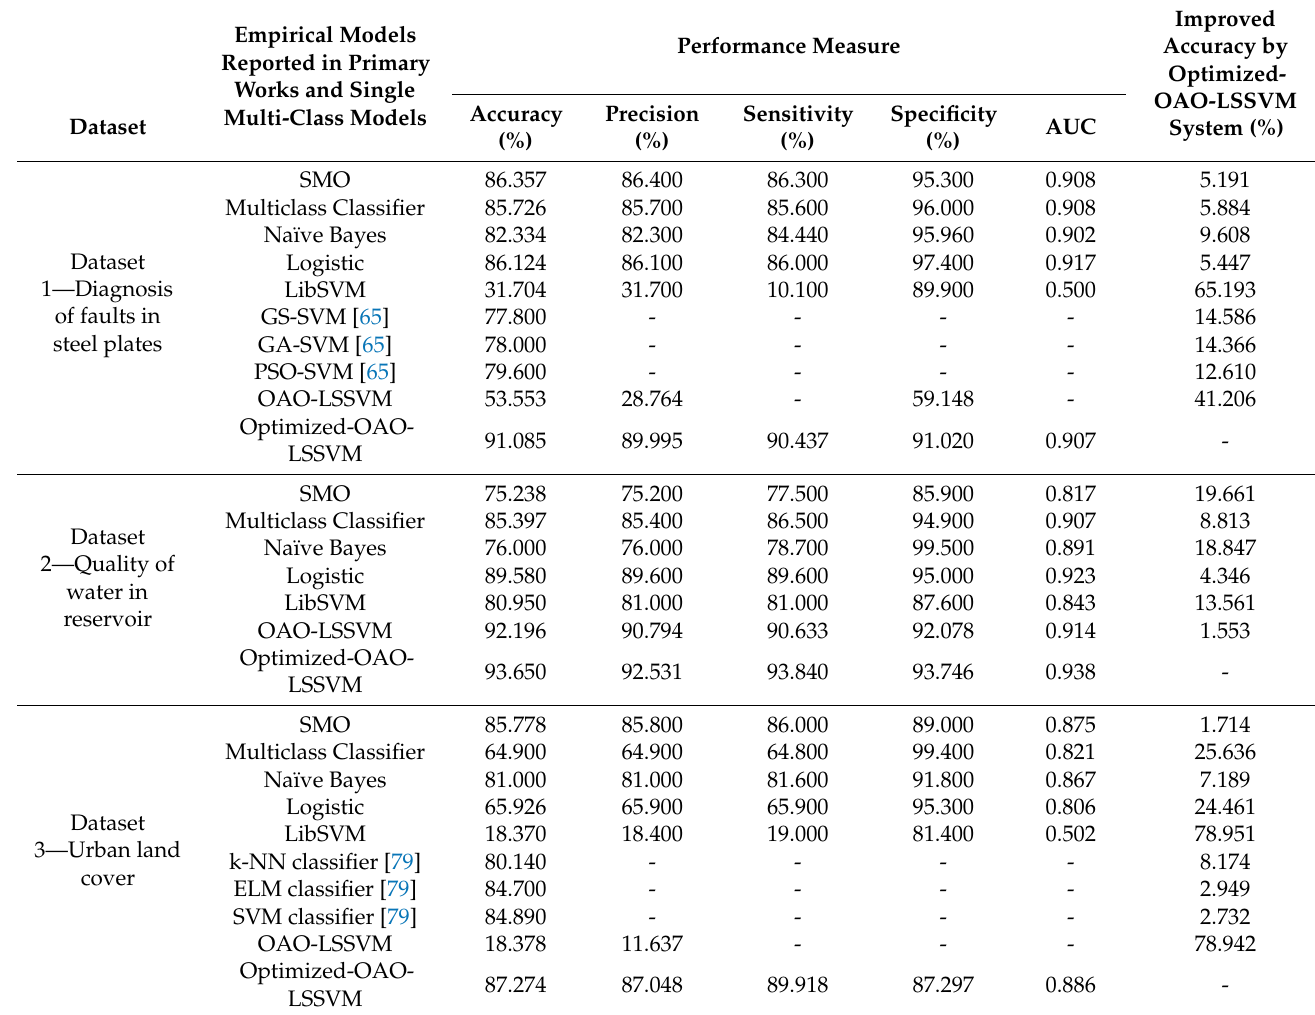
Table 7. Results of performance measures and rates of improved accuracy achieved by